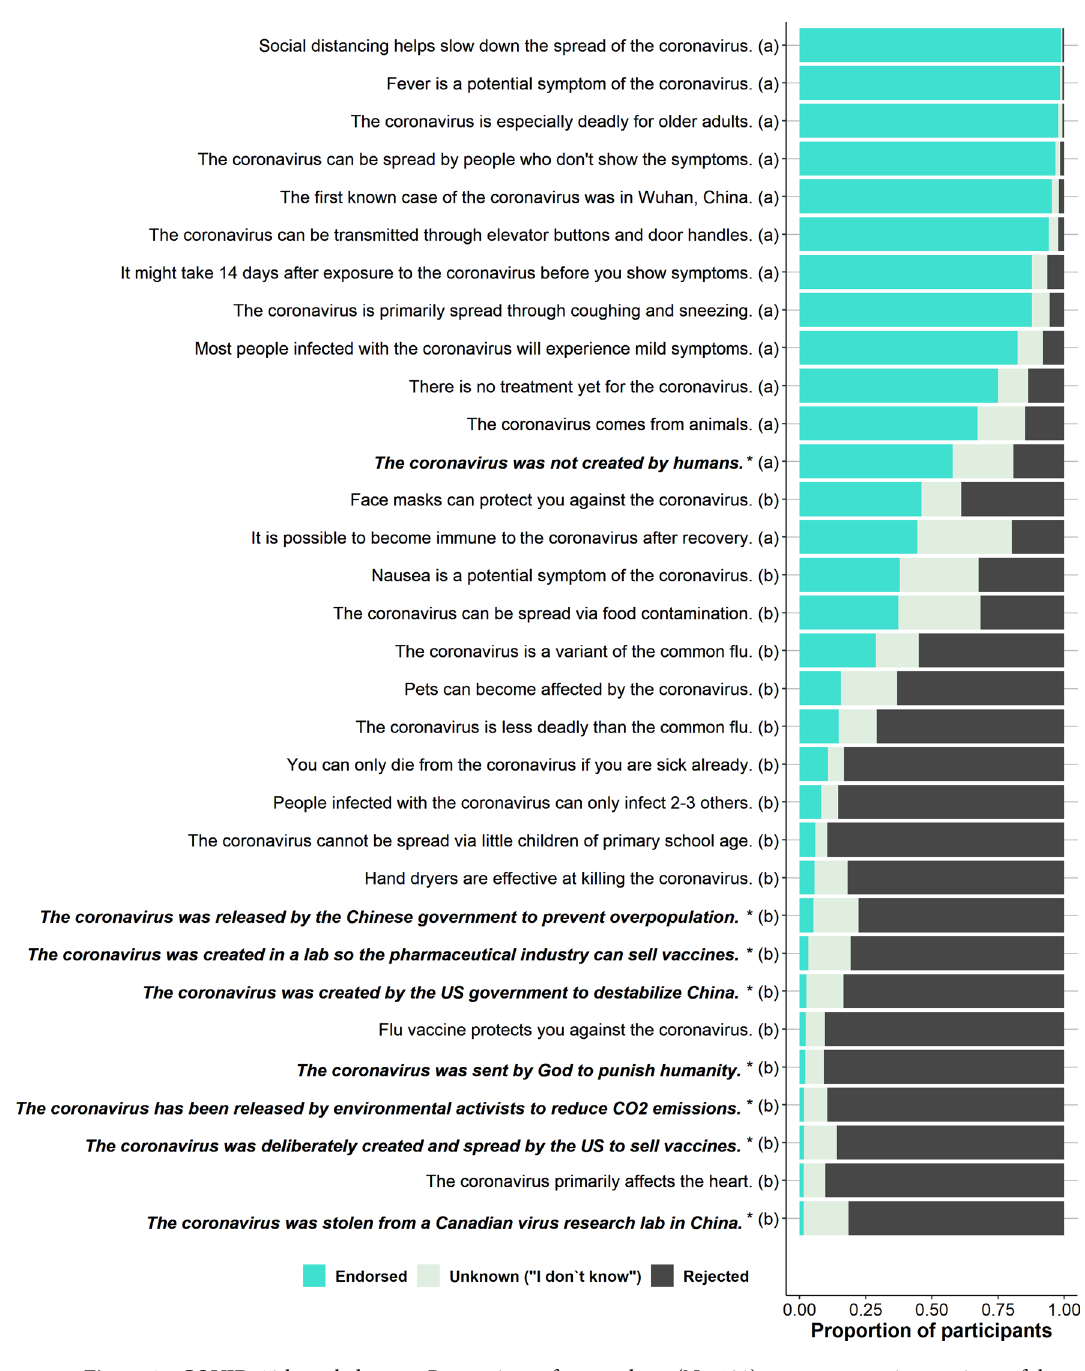
Figure 1. COVID-19 knowledge test . Proportions of respondents (N = 501) per answer option per item of the COVID-19 Knowledge Test . ( a ) = true statement, ( b ) = false statement, *conspiracy statement. See Appendix C for comparisons between groups based on NC and NCC scores Cognitive motivation. To compare the results of the COVID-19 Knowledge Test between different NC and NCC combinations we extracted four subsets from our sample. We used a median split to determine whether a respondent was high or low in NC. Whether respondents were high or low in NCC was based on the top and bottom quartiles of the NCC scores, a procedure suggested by the authors of the NCC test 16 . The discrepancy in categorization methods of NC and NCC groups (i.e., median split and outer quartiles) was chosen for pragmatic reasons. That is, excluding the data of two independent measures’ interquartile ranges would vastly diminish the number of observations per cell. Group sizes were 61 (Hi-NC, Hi-NCC), 78 (Hi-NC,Lo-NCC), 61 (Lo-NC, Hi-NCC), and 52 (Lo-NC, Lo-NCC). An important consideration here is that these groups were solely categorized for descriptive purposes and were not used in the inferential analyses. The descriptive results of the NC and NCC scales and subscales can be found in Supplementary Table 6 in Appendix